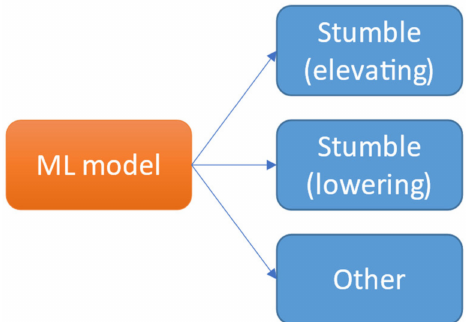
Figure 6. Single machine learning model to classify data into three classes.